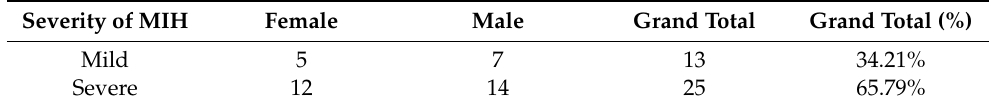
Table 4. Severity of MIH according to the EAPD.